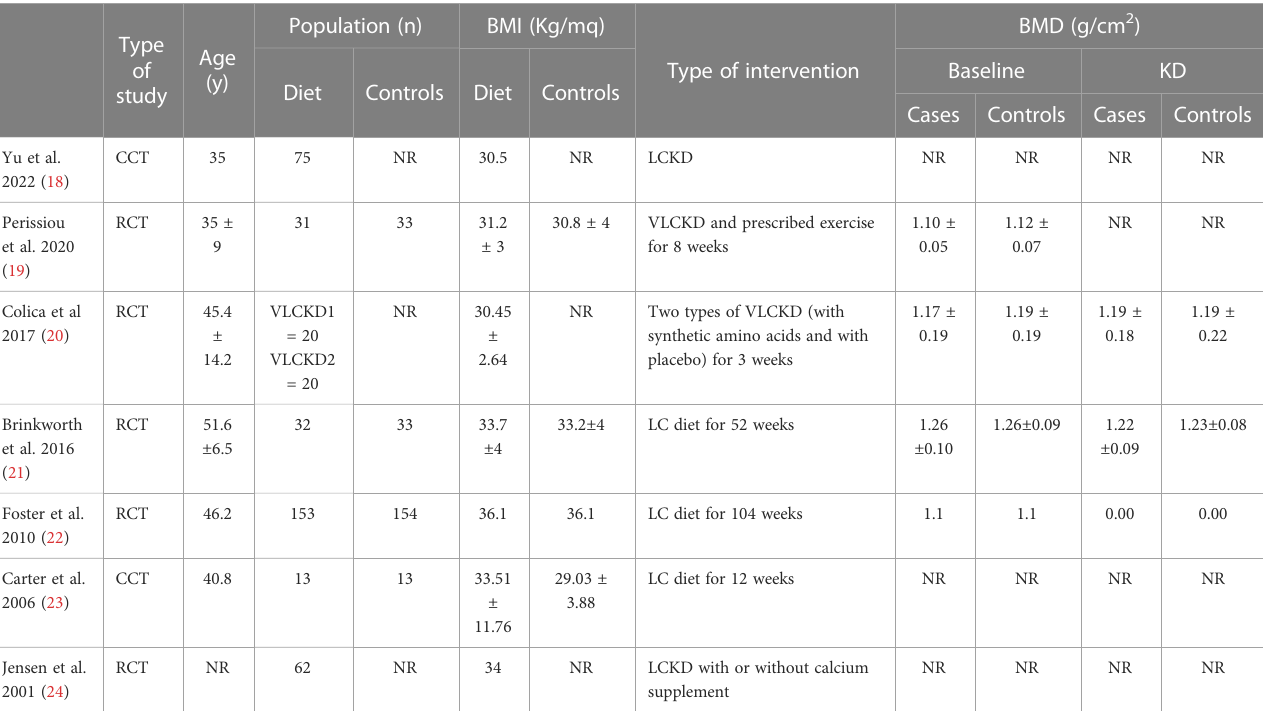
TABLE 3 Main characteristics of the studies included in the